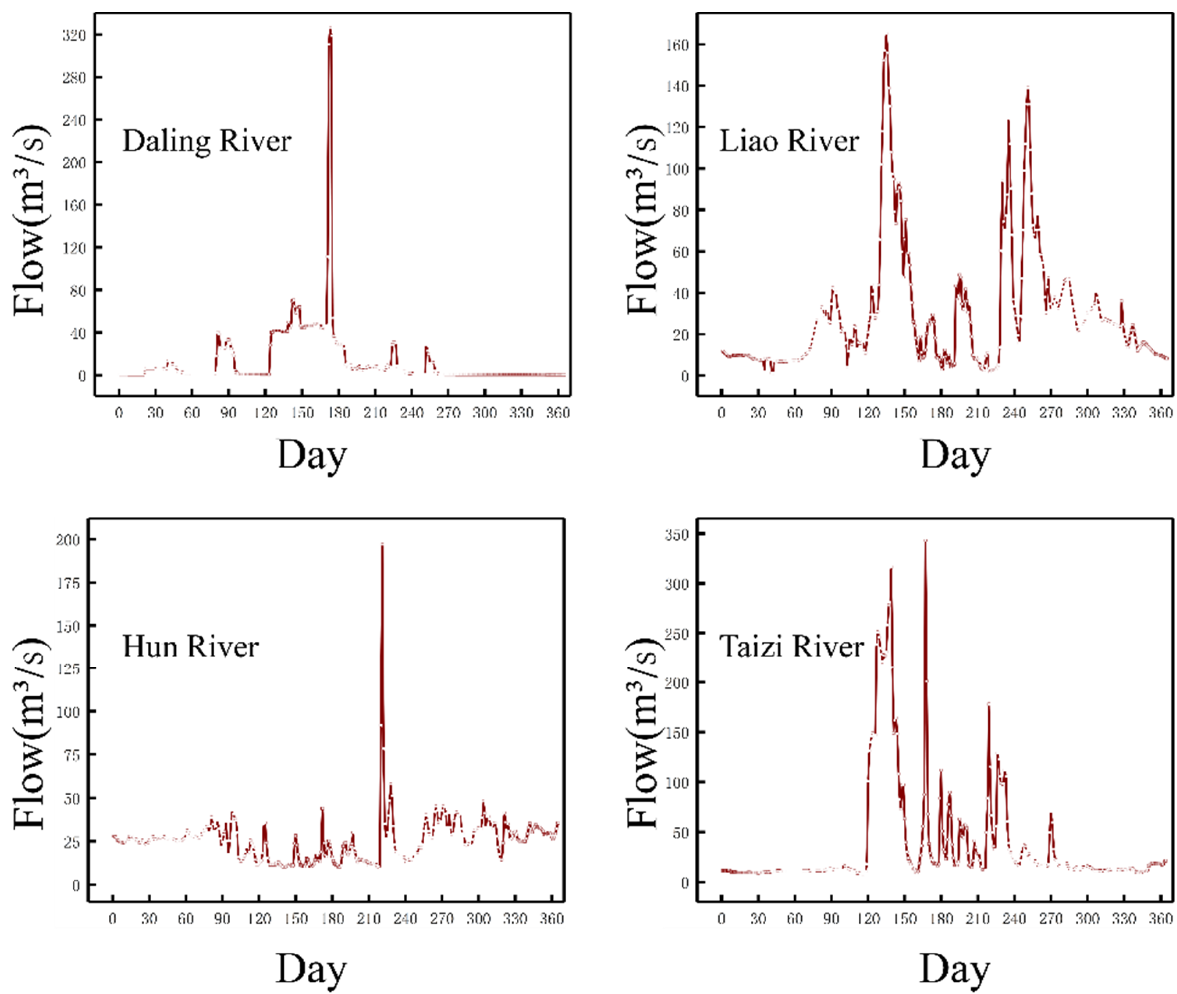
Figure 2. The flow velocity of rivers.